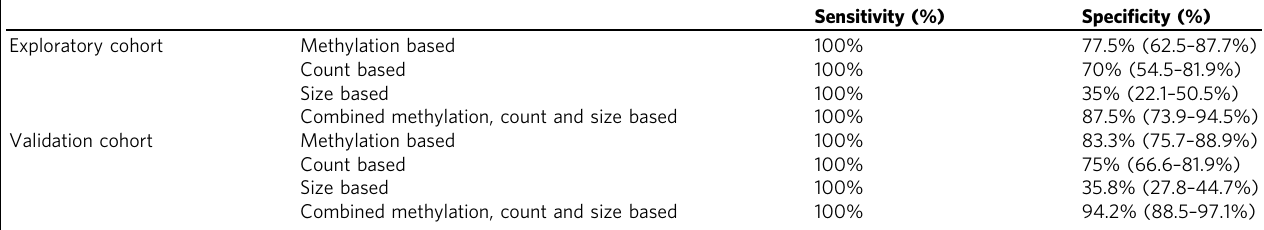
Table 2 Sensitivities and speci fi cities of the isolated and combined analysis at the de fi ned cutoffs in both exploratory and validation cohorts. The corresponding 95% con fi dence intervals are